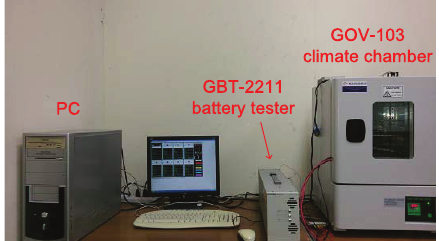
Figure 7. Experimental setup of the model